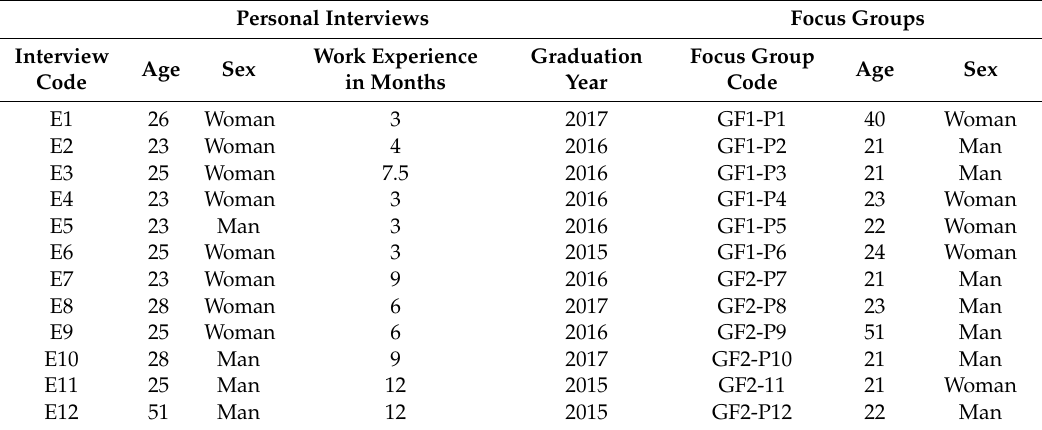
Table 1. The sociodemographic data of interviewees and participants of the focus